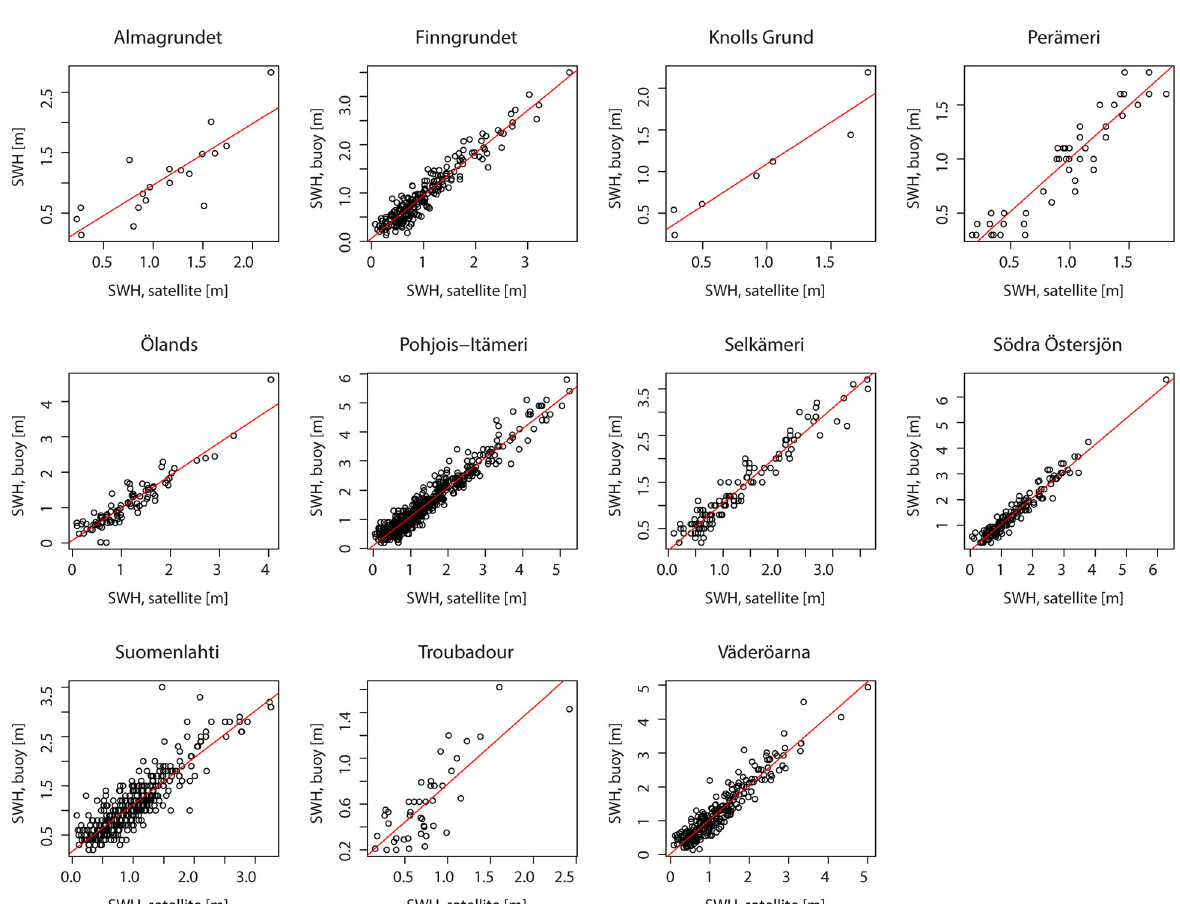
Fig. 3. JASON-1 significant wave heights versus in situ measured significant wave